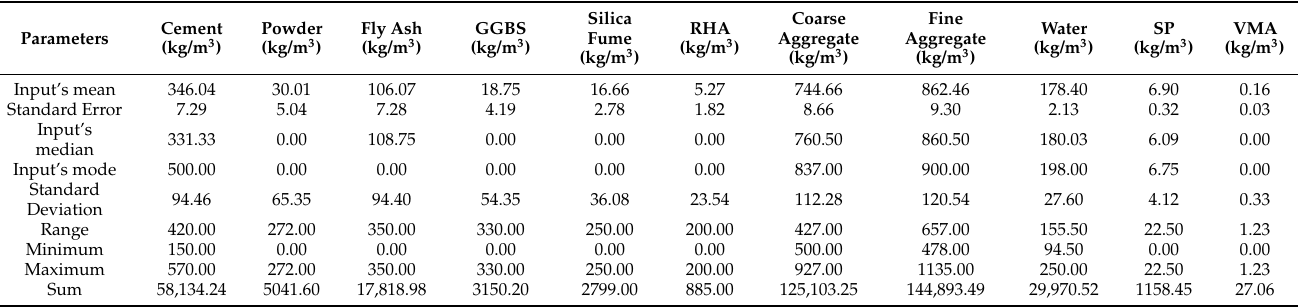
Table 1. Descriptive statistics of